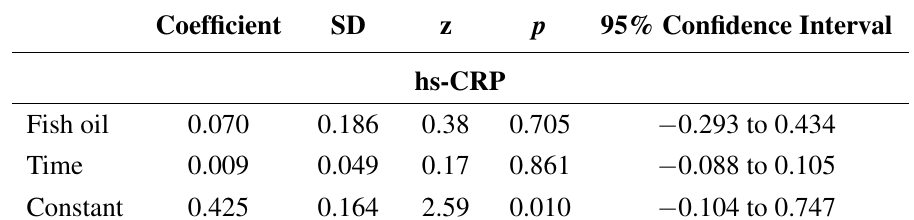
Table 4. Primary endpoints—Multilevel